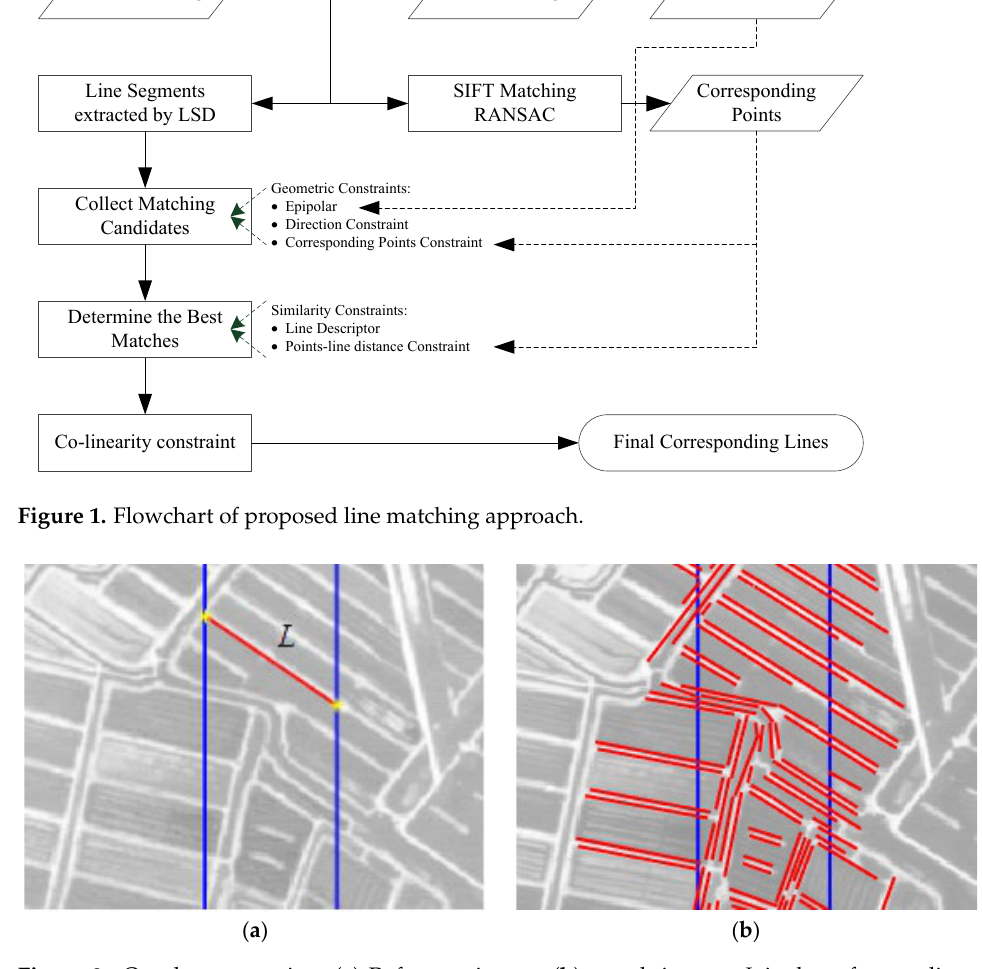
Figure 1. Flowchart of proposed line matching approach.